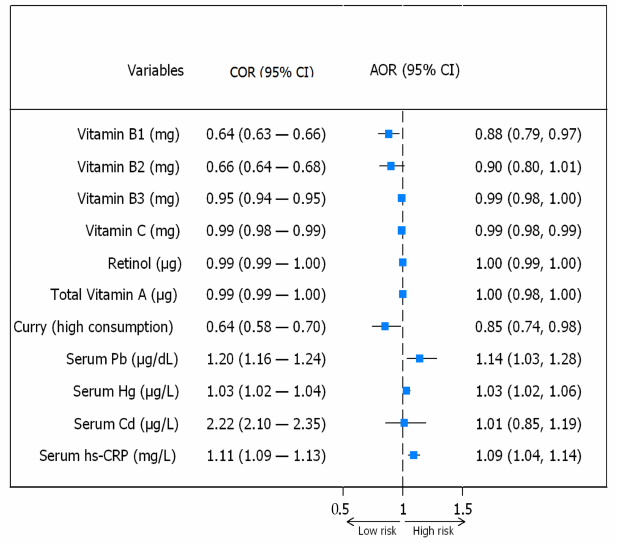
Figure 1. Crude odds ratio and adjusted odds ratio (95% confidence interval) for risks of MetS.